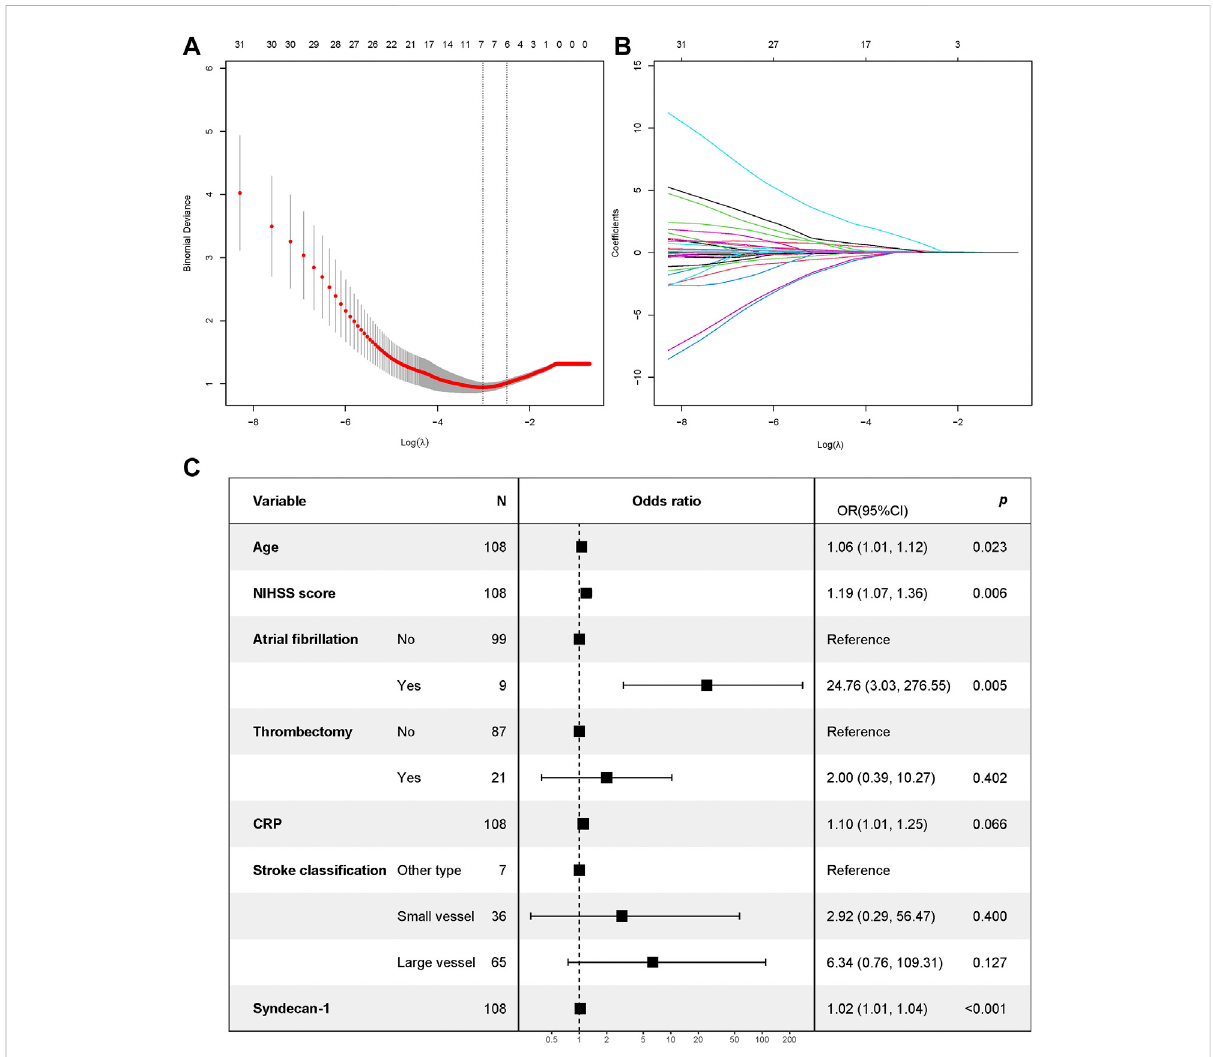
FIGURE 3 Screening of characteristic variables based on LASSO regression and forest map of factors in fl uencing prognosis as determined using logistic regression. (A) The process of selecting the most suitable value for λ in the LASSO model via cross-validation method. When λ = 0.04902451 and seven parameters are selected, the LASSO regression model is most suitable; (B) The fi gure shows the characteristics of the variable coef fi cients. LASSO, least absolute shrinkage and selection operator; (C) Forest map. Note: An mRS of > 2 points at 3 months was used as the dependent variable. The independent variables included age, NIHSS score, atrial fi brillation, mechanical thrombectomy, CRP, stroke classi fi cation, and syndecan-1 levels (screened out via LASSO regression). mRS, modi fi ed Rankin scale; NIHSS, National Institutes of Health Stroke Scale; CRP, C-reactive protein; LASSO, least absolute shrinkage and selection